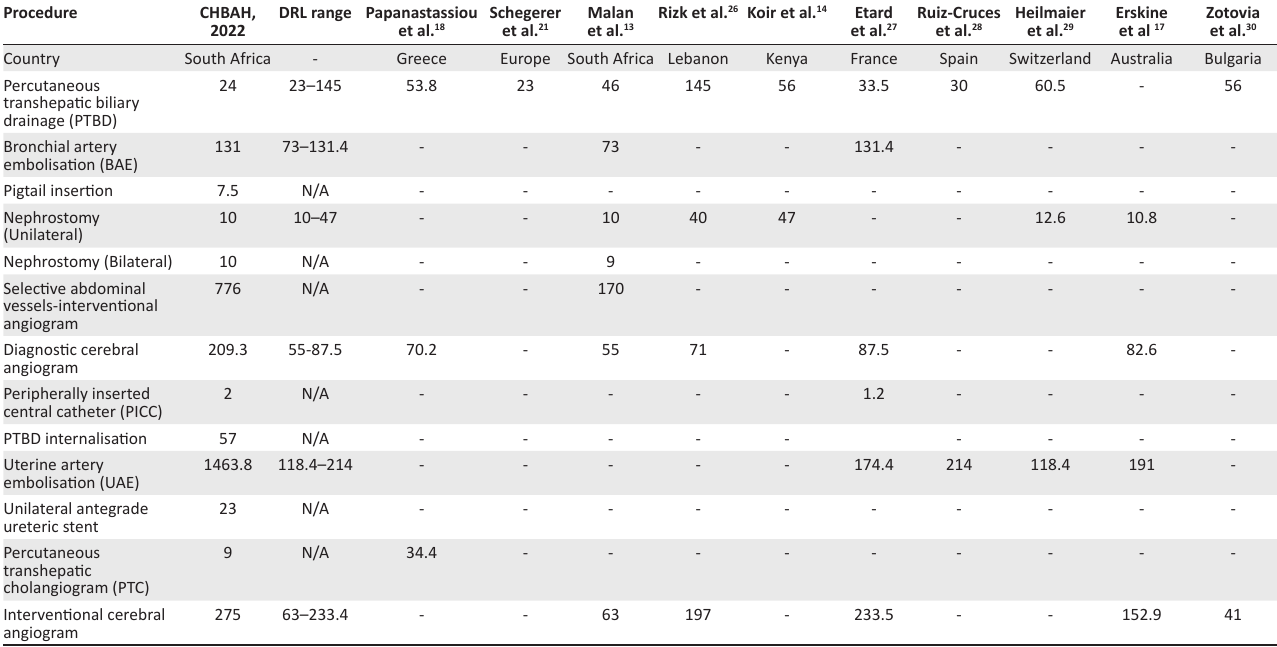
TABLE 2a: Comparison with published data on kerma air product and diagnostic reference levels. Procedure CHBAH, 2022